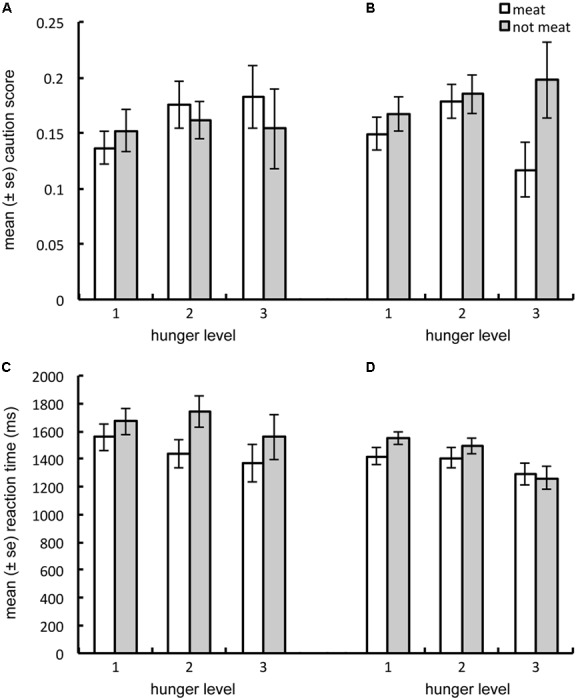
Shows that as hunger increases, men tend to increase caution (A) and decrease reaction time (C) in response to meat, compared to non-meat; while women to increase caution (B) and decrease reaction time (D) to non-meat, compared to meat images. The multivariate three-way interaction between hunger level, sex and food-type, approached significance only, however, p = 0.061.